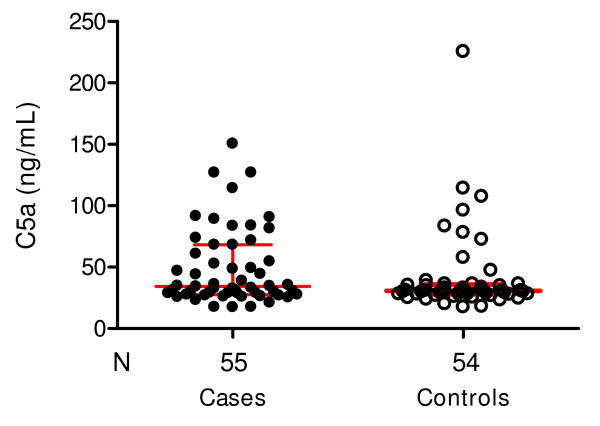
Scatter plots showing median and interquartile range of C5a levels in severe malarial anaemia (cases) and those with uncomplicated malaria (controls). The median level in the cases (34.3 ng/mL, 27.7–68.2) was comparable to the level in the control group (30.7 ng/mL, 28.1–35.8), P = 0.35). Wilcoxon matched-pairs signed-ranks test was performed with the 54 paired samples.